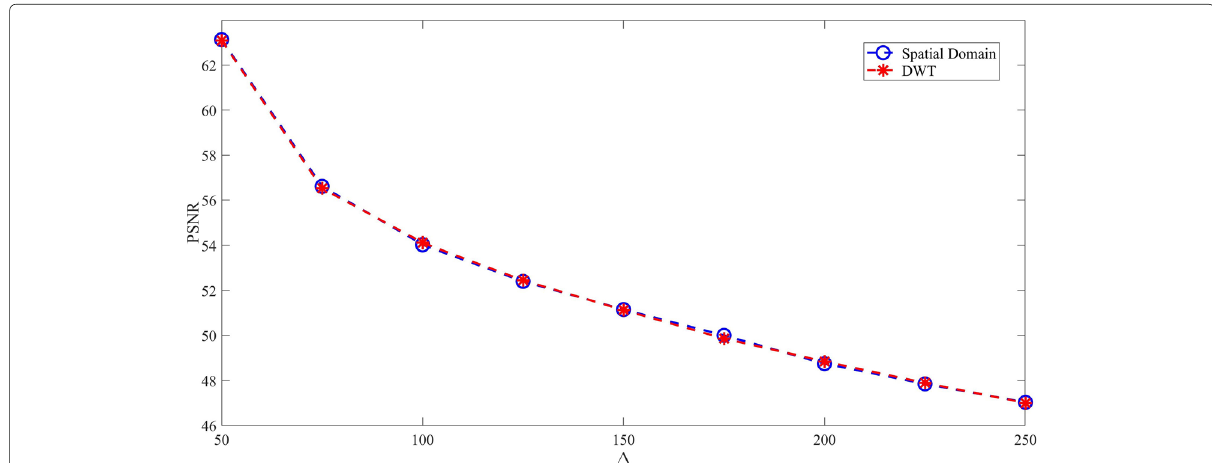
Fig. 7 PSNR versus (cid:2) in the spatial and the DWT domain (averaged over 50